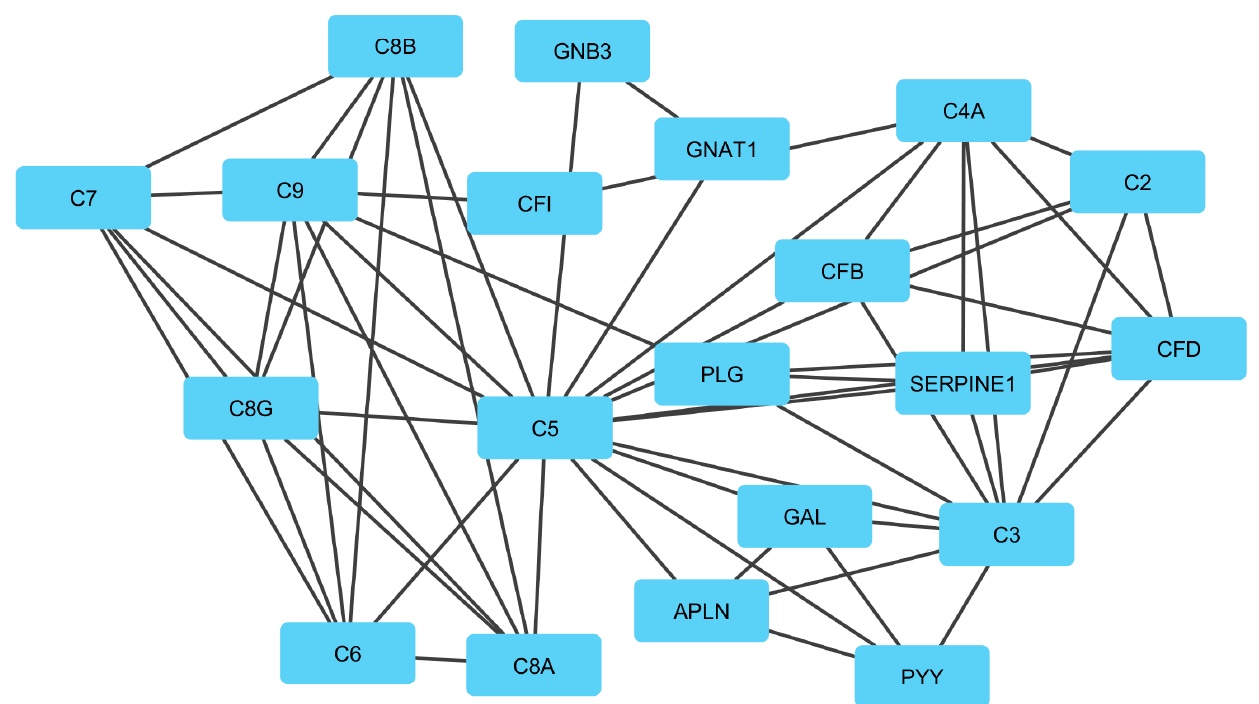
Figure 5. Module 2: 20 genes in an interactive network of genes. In this network, the quadrilateral nodes represent genes, and edges indicate the gene–gene interaction effects.